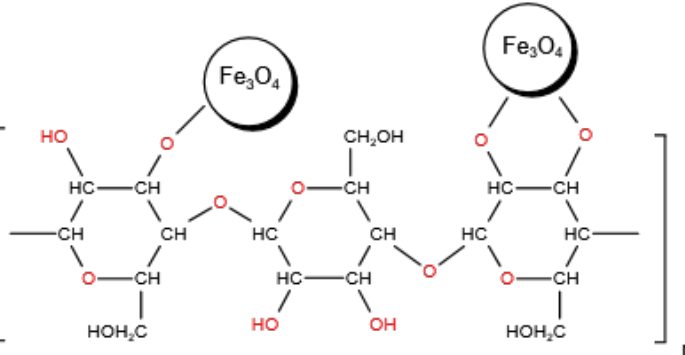
Figure 10. Fe 3 O 4 NP binding with cellulose molecules.